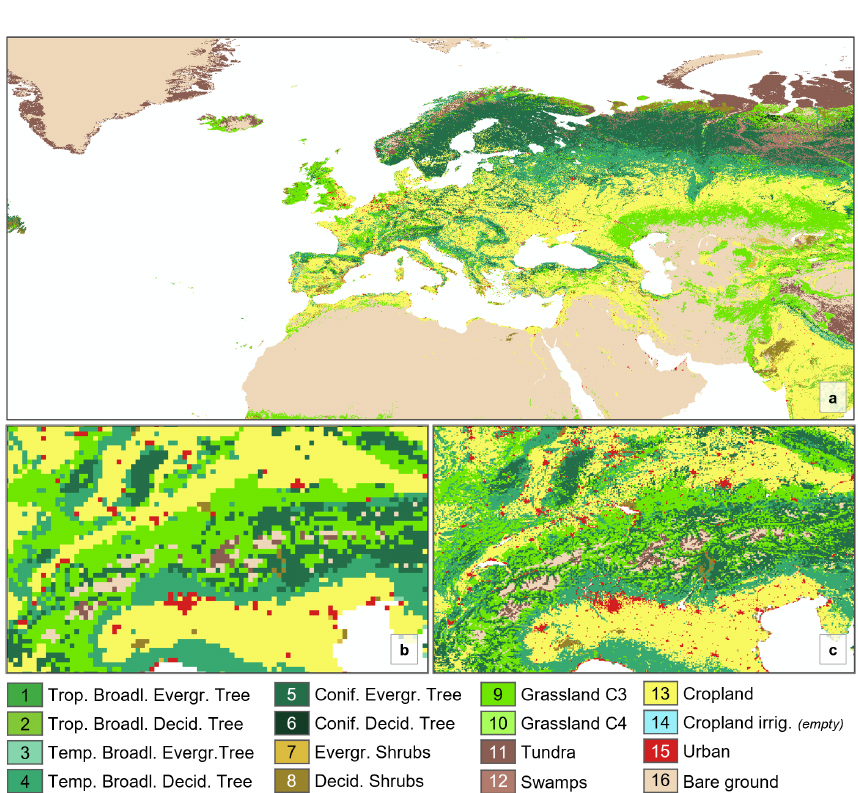
Figure 3. LANDMATE PFT map for Europe for 2015 (a) . Below a map section of the Alpine region shows an example of the resolution difference between LANDMATE PFT 0.1 (b) and LANDMATE PFT 0.018 (c) . LANDMATE PFT 0.018 is used in the present accuracy assessment. For improved visualization, all maps show the majority PFT per grid cell. The irrigated cropland PFT (14) is not used in this map. More information is given in Sect.